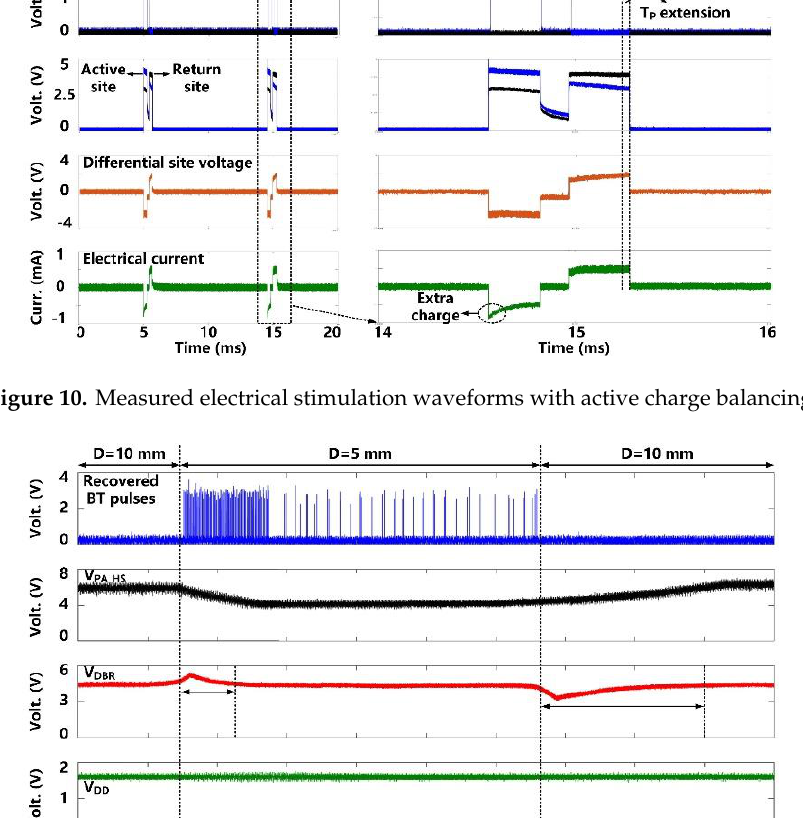
Figure 11. Measured waveforms under CLPC operation, when moving the headstage to change the distance between L Tx and L Res , D .